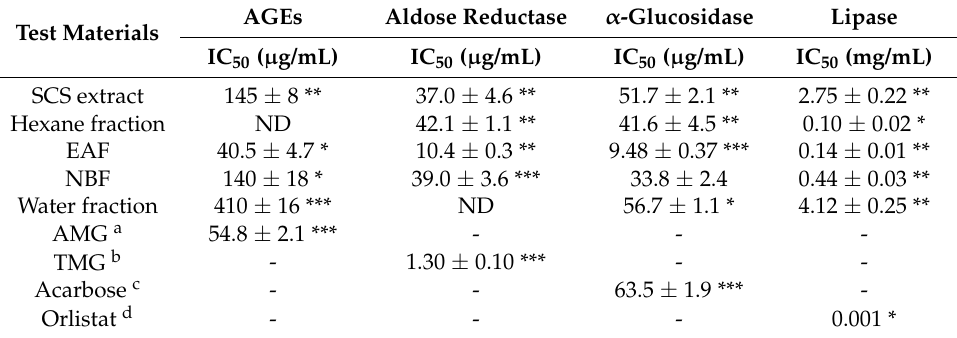
Table 2. Inhibitory effect of SCS and solvent fractions on AGEs formation, AR, of α -glucosidase and lipase